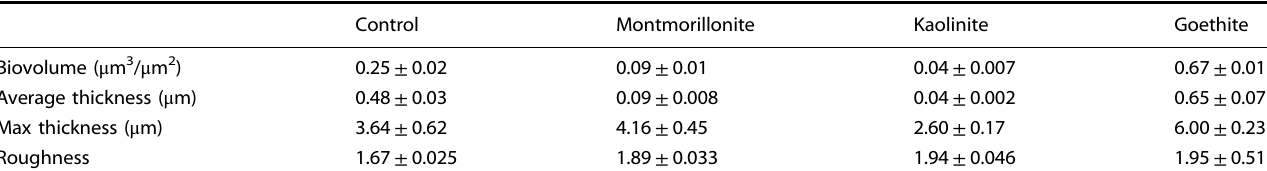
Table 1. Bio fi lm structural parameters and biomass content at 48 h